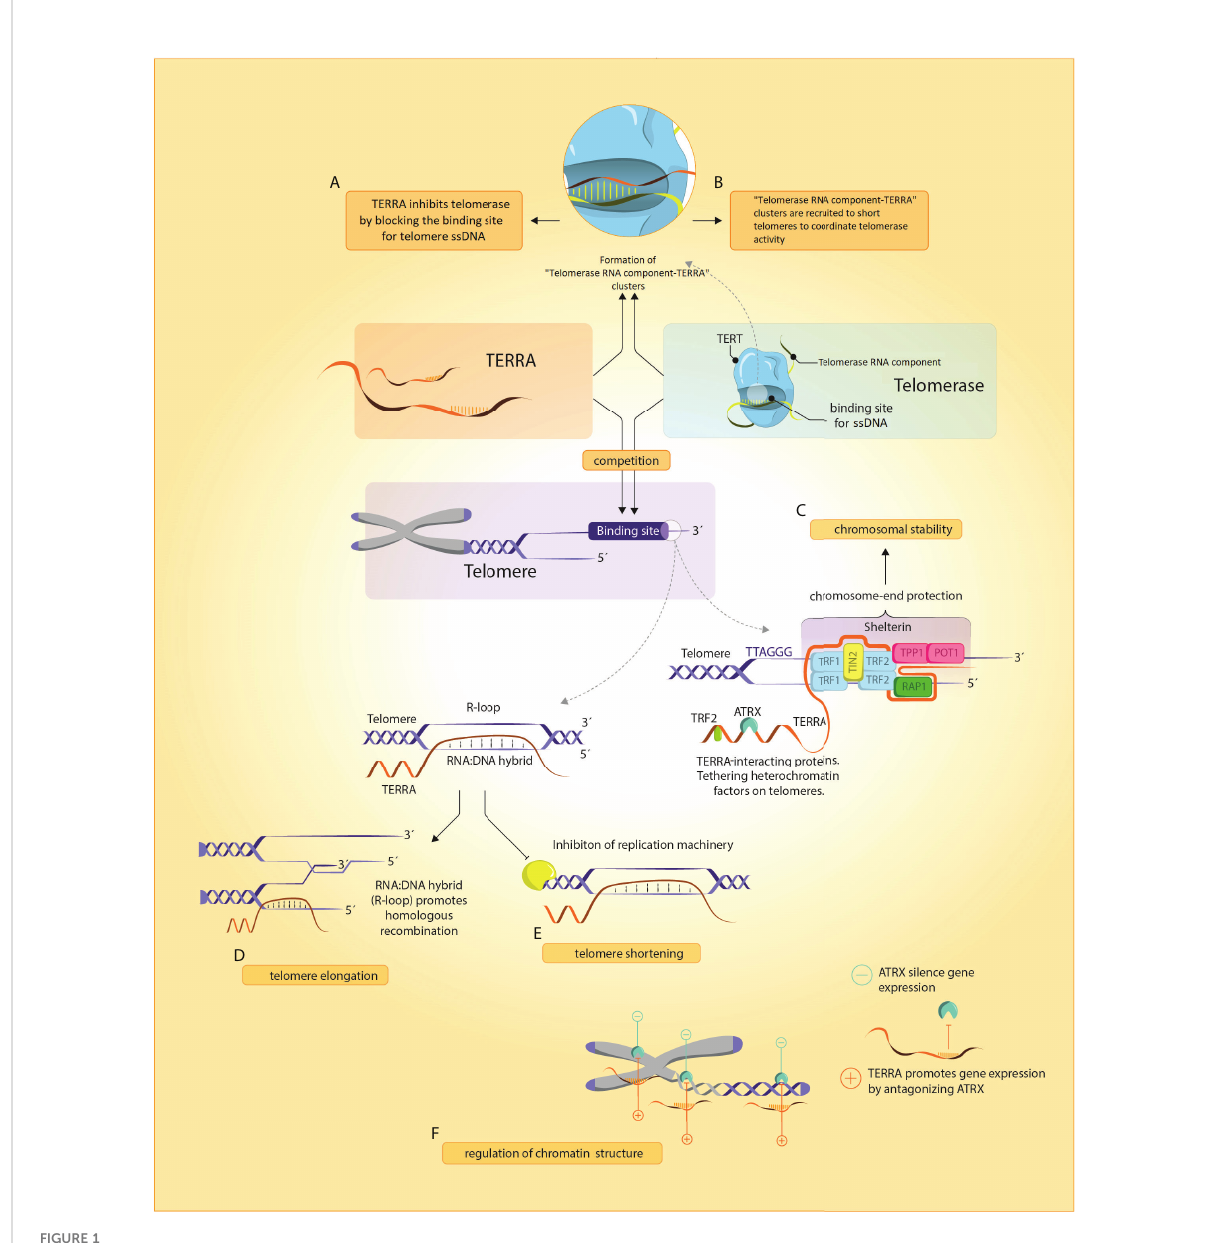
FIGURE 1 TERRA and its functions. (A, B) TERRA presumably binds to Telomerase RNA component through base-complementary pairing and blocks telomerase binding to telomeric ssDNA. In yeasts, Telomerase RNA component-TERRA clusters are localized at short telomeres where they coordinate telomerase activity, (C) TERRA and shelterin are implicated in chromosome-end protection by assembling secondary protective structures including R- and T-loops and G-quadruplexes (D, E) Regulation of telomeres by TERRA can induce either a shortening (by inhibition of telomerase activity and repressing TERT expression) or elongation (by homologous recombination promotion), (F) TERRA remodels chromatin structure through an antagonistic interaction with